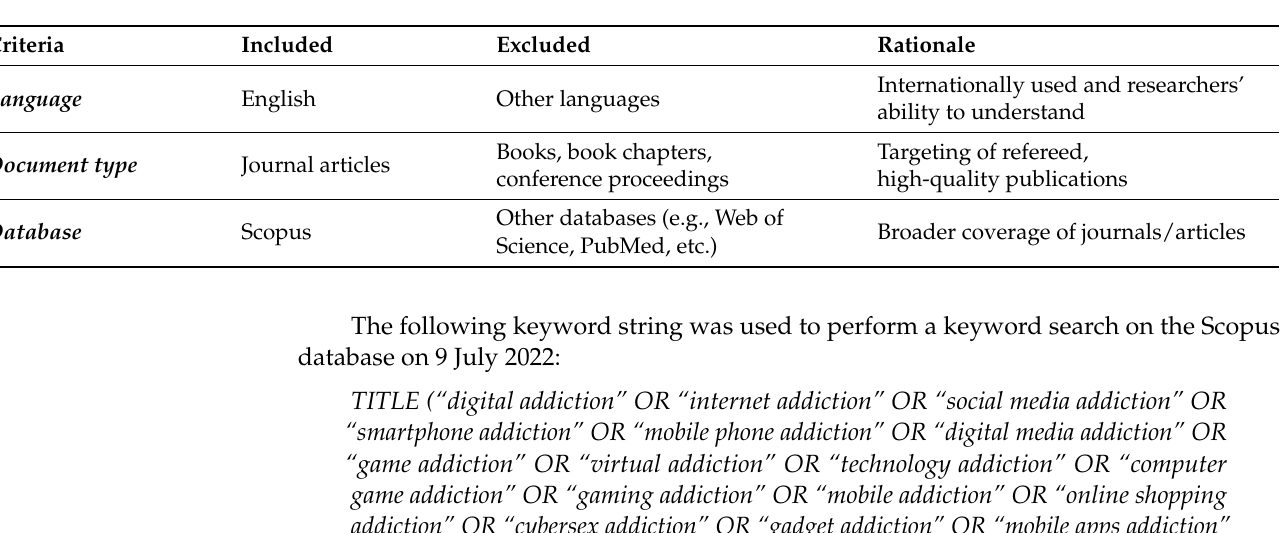
Table 1. Inclusion/exclusion